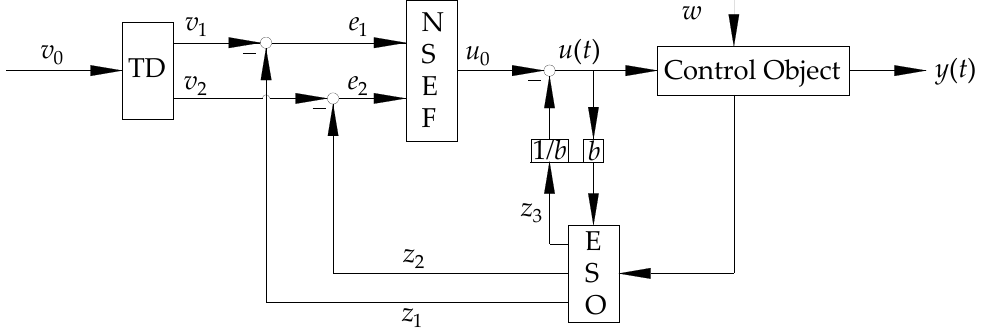
Figure 2. The structure of the ADRC. TD, tracking differentiator; NSEF, nonlinear state error feedback; ESO, extended state observer.